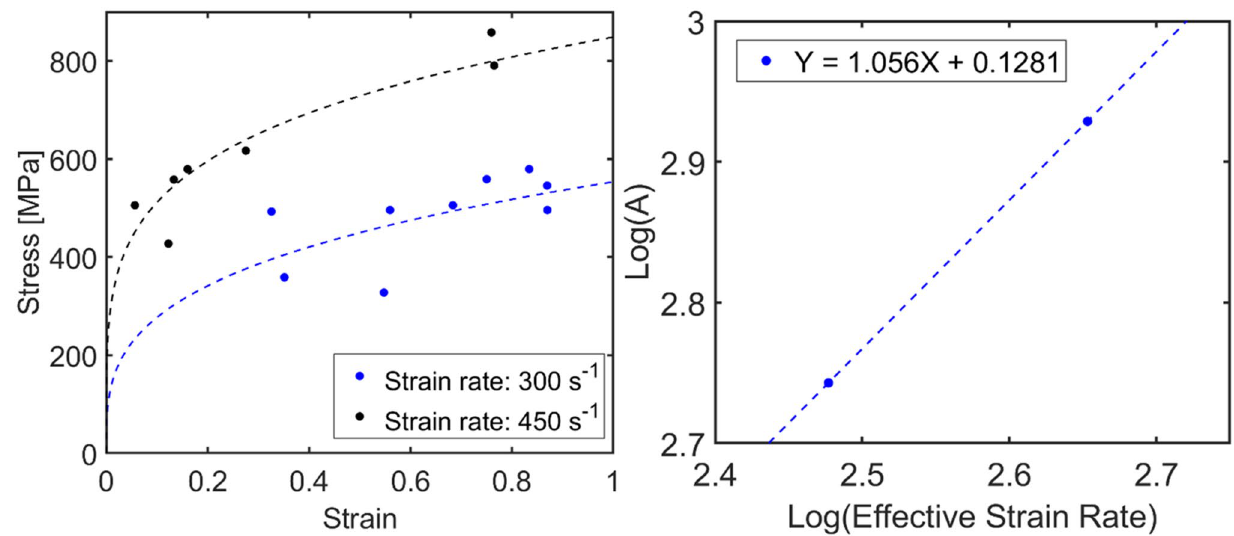
Fig. 10 Viscoplastic model parameters are obtained by fitting impact data to viscoplastic power law from 100